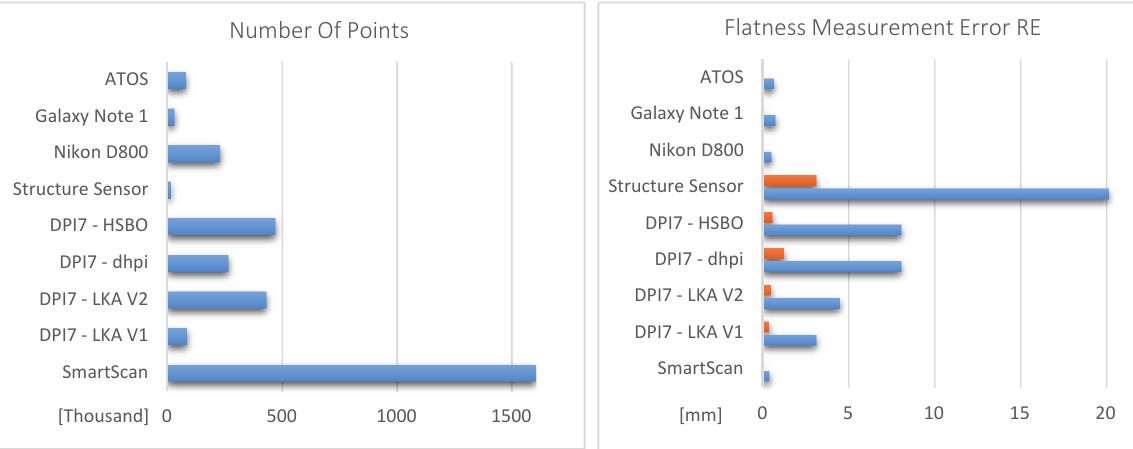
Figure 5. Quality parameter flatness measurement error (RE) equivalent to VDI/VDE 2634, part 2. Right figure: BLUE – flatness measurement error, ORANGE: standard